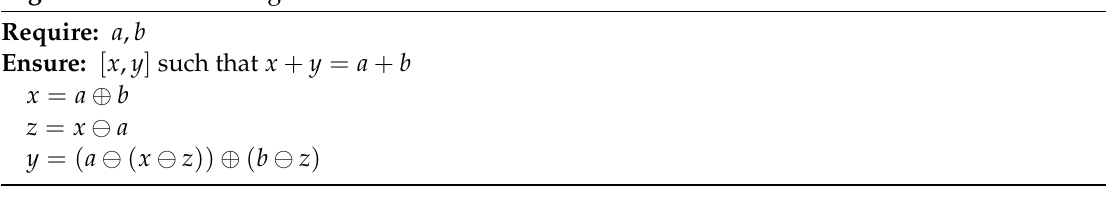
Algorithm 2 TwoProduct